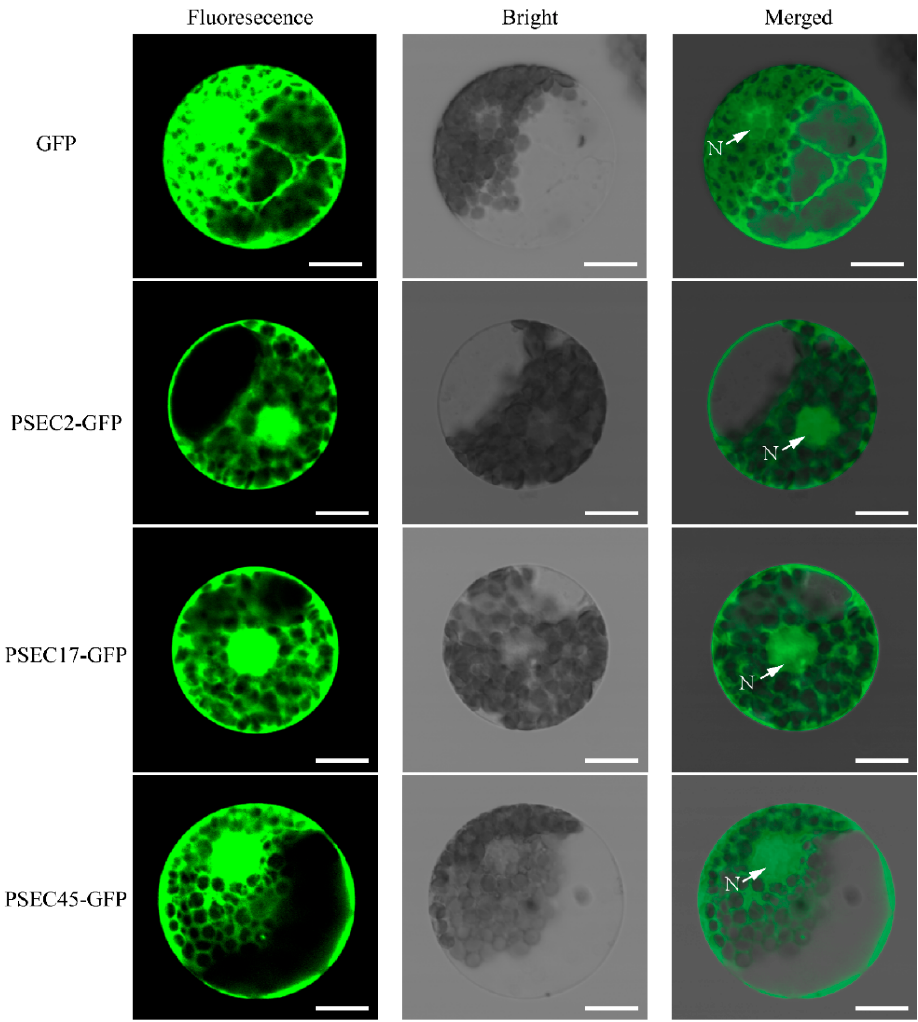
Figure 10. Subcellular localization of PSEC2, PSEC17, and PSEC45 in wheat protoplasts. GFP, PSEC2-GFP, PSEC17-GFP, and PSEC45-GFP fusion proteins were expressed in wheat protoplasts following PEG-mediated transformation. N, nucleus. Bar = 20 μ m.